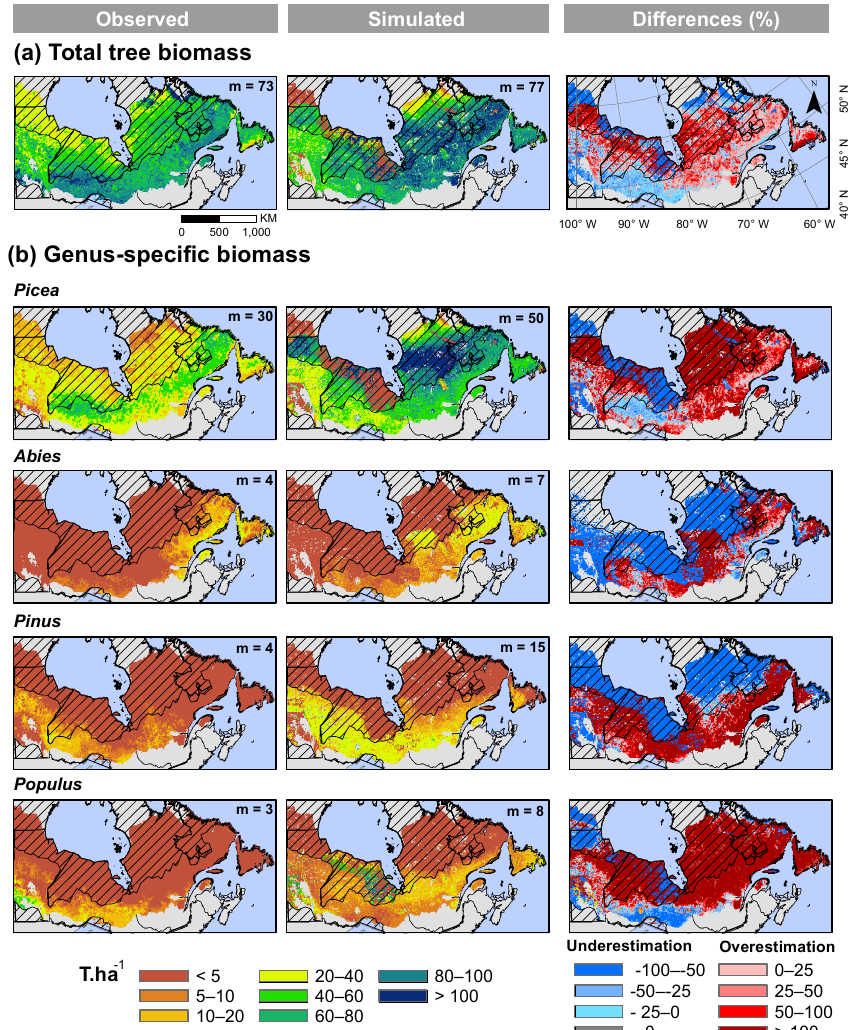
Figure 4. (a) Observed, LPJ-LMfire simulated, and differences (%) in mean total aboveground biomass (Tha − 1 ) between 2000 and 2006 across eastern boreal Canada. (b) Genus-specific aboveground biomass. The observed aboveground biomass maps across Canada were predicted and validated with photo-plot information in the southern areas (non-hatched areas) and data published by Beaudoin et al. (2014). Median ( m ) tree aboveground biomass values are also indicated for each map; these were calculated for the non-hatched areas at a 10km